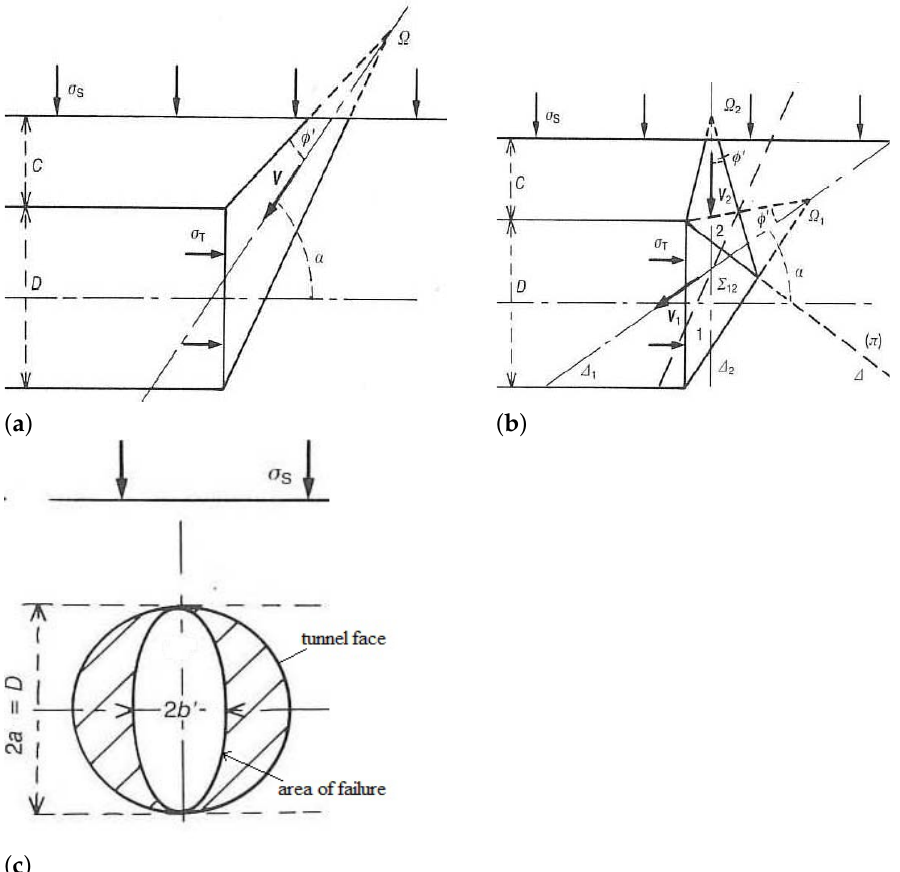
Figure 4. Upper bound failure mechanisms, Leca and Dormieux [13] ( a ) One conical failure mecha- nism ( b ) Two conical failure mechanisms ( c ) Cross section of the tunnel